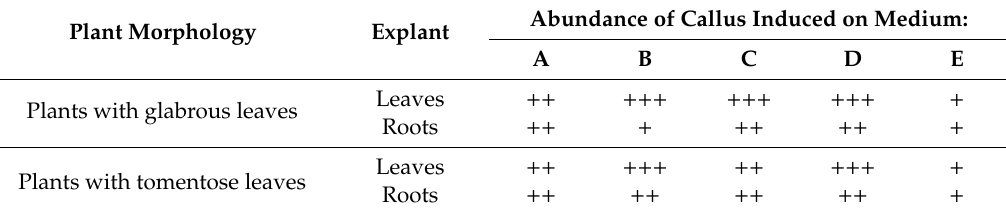
Table 1. E ff ectiveness of callus induction in di ff erent variants of Murashige & Skoog Medium. Abundance of Callus Induced on Medium: Plant Morphology Explant A B C D E Leaves Plants with glabrous leaves Plants with tomentose leaves Callus: +++ abundant, ++ moderate, + poor; medium: (A) with indole-3-butyric acid (0.5 mg · L − 1 )